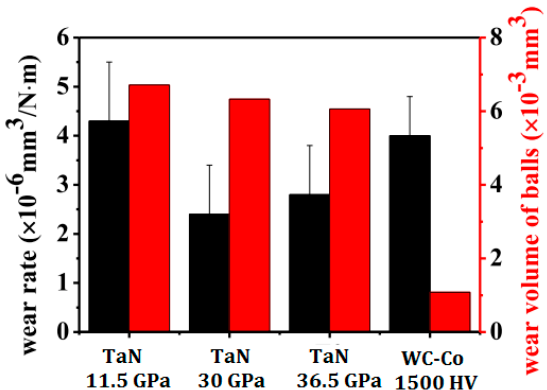
Figure 18. Wear rate of 2.5–3 µ m thick TaN coatings deposited on WC-Co substrate using the reactive magnetron sputtering technique, and wear volume of steel balls, reprinted from Tribology International , Reference [134], with permission from Elsevier.